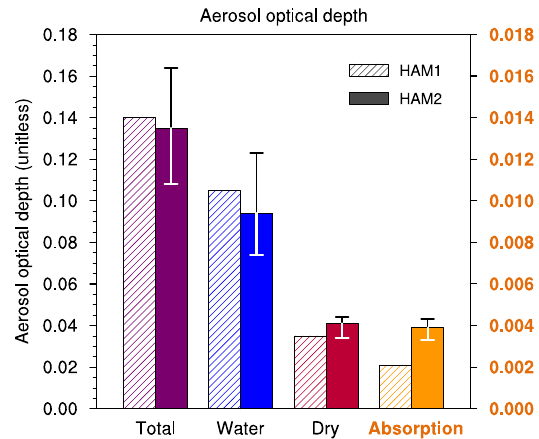
Fig. 19. Global and annual mean aerosol optical depth simulated by HAM1 and HAM2, the corresponding contributions from aerosol water and dry mass, as well as the absorption AOD. Whiskers as- sociated with the HAM2 results indicate the ranges given by the sensitivity experiments listed in Table 4. Note that the absorption AOD is displayed with a different